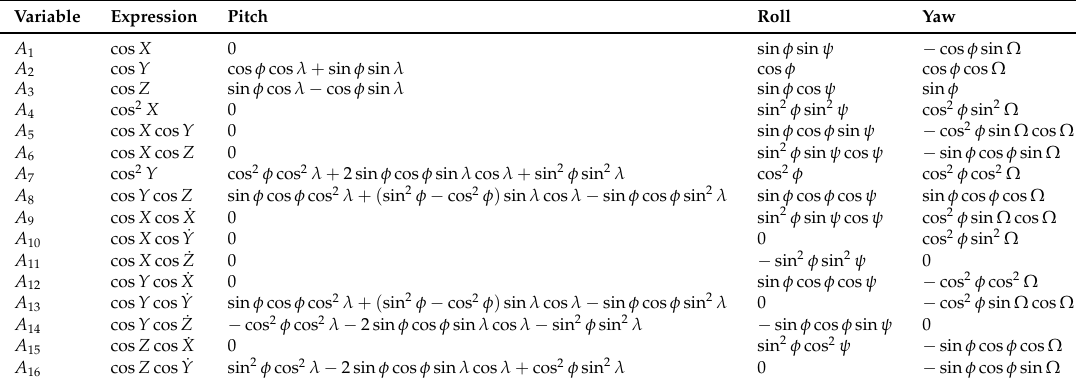
Table 1. Model variables in the north